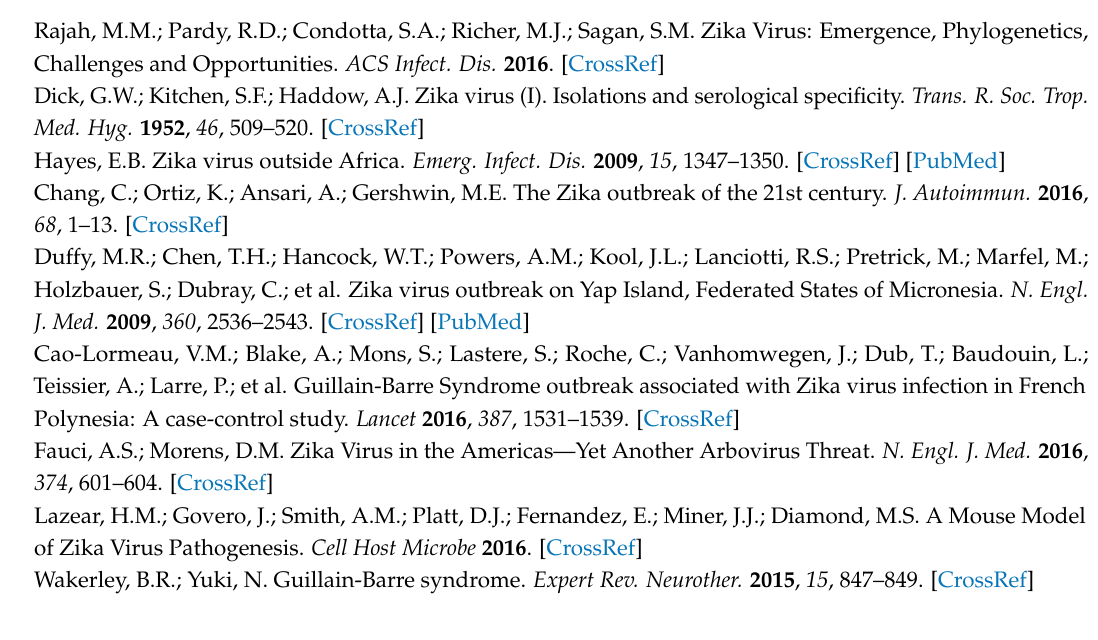
s1, Table S1. List of ZIKV Genbank accession numbers of sequences used in phylogenetic analysis, Table S2. Source host, isolation, and passage history of ZIKV strains used in this study, Table S3. Percent amino acid identity matrix of the ZIKV isolates used in this study, Figure S1. Phylogenetic analysis of ZIKV isolates, Figure S2. ZIKV isolates differentially induce apoptosis, Figure S3. ZIKV isolates differ in infectivity at low MOI, File S1. Amino acid sequence alignment of the ZIKV isolates used in this